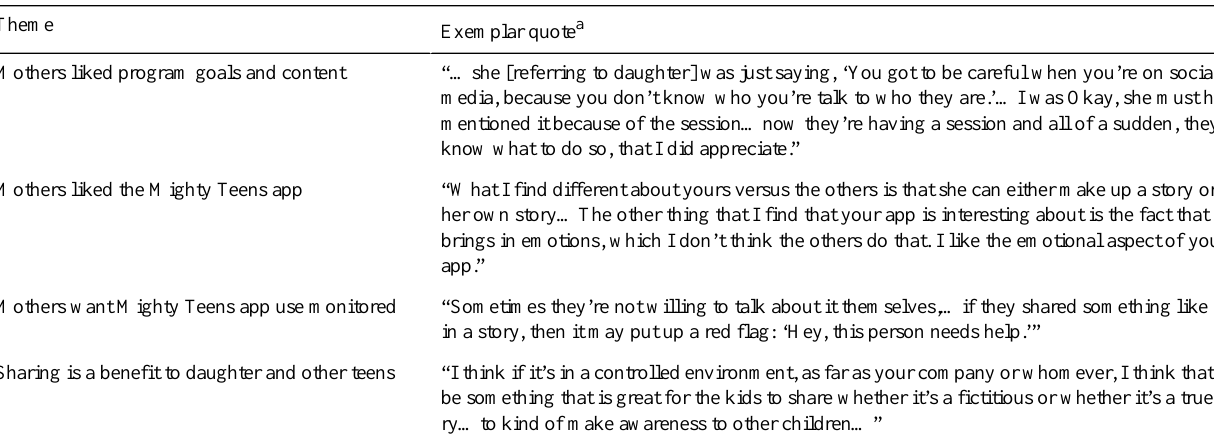
Table 2. Themes identified in parent focus groups.